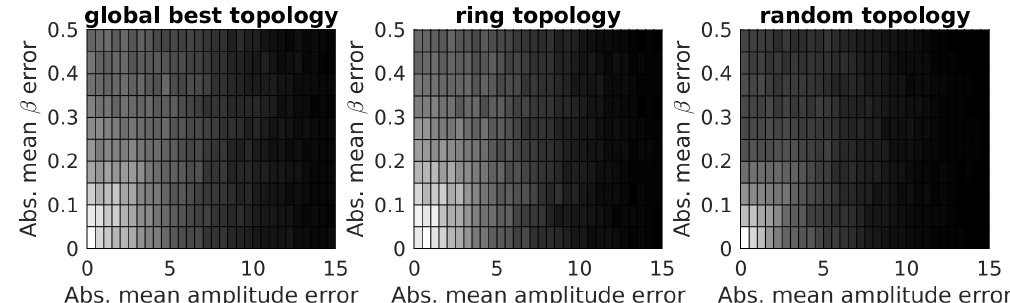
Figure 7. The relation of absolute mean amplitude error and absolute mean β error.